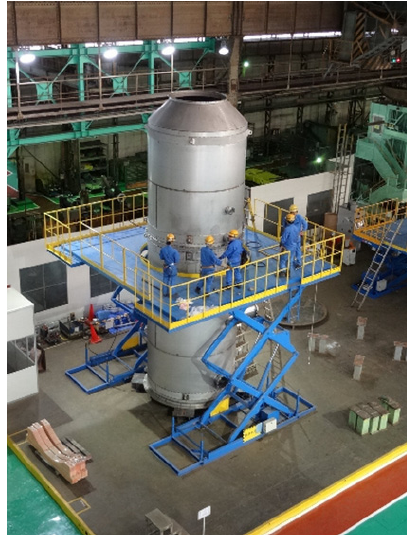
Figure 9. SO x scrubber using cyclone technology [105].